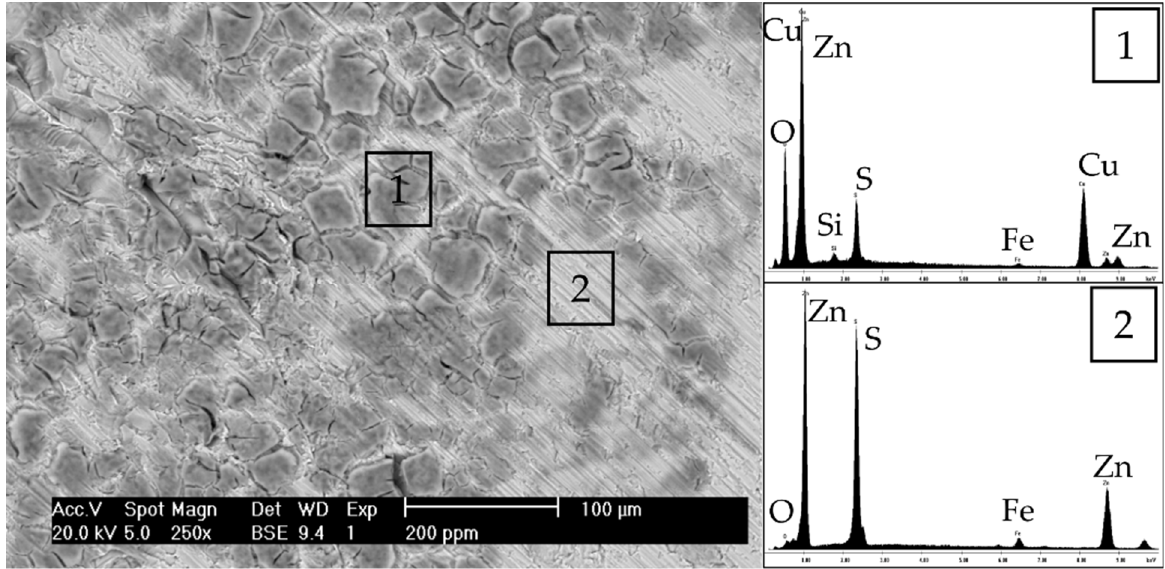
Figure 3. SEM micrograph and microprobe analysis showing Cu(OH) 2 adsorption/precipitation onto the sphalerite surface conditioned at pH 9 with 200 mg/L of Cu(II).